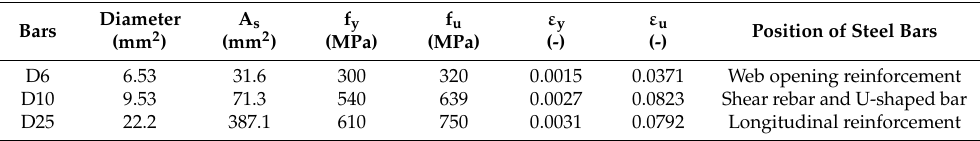
Table 2. Mechanical properties of steel bars.